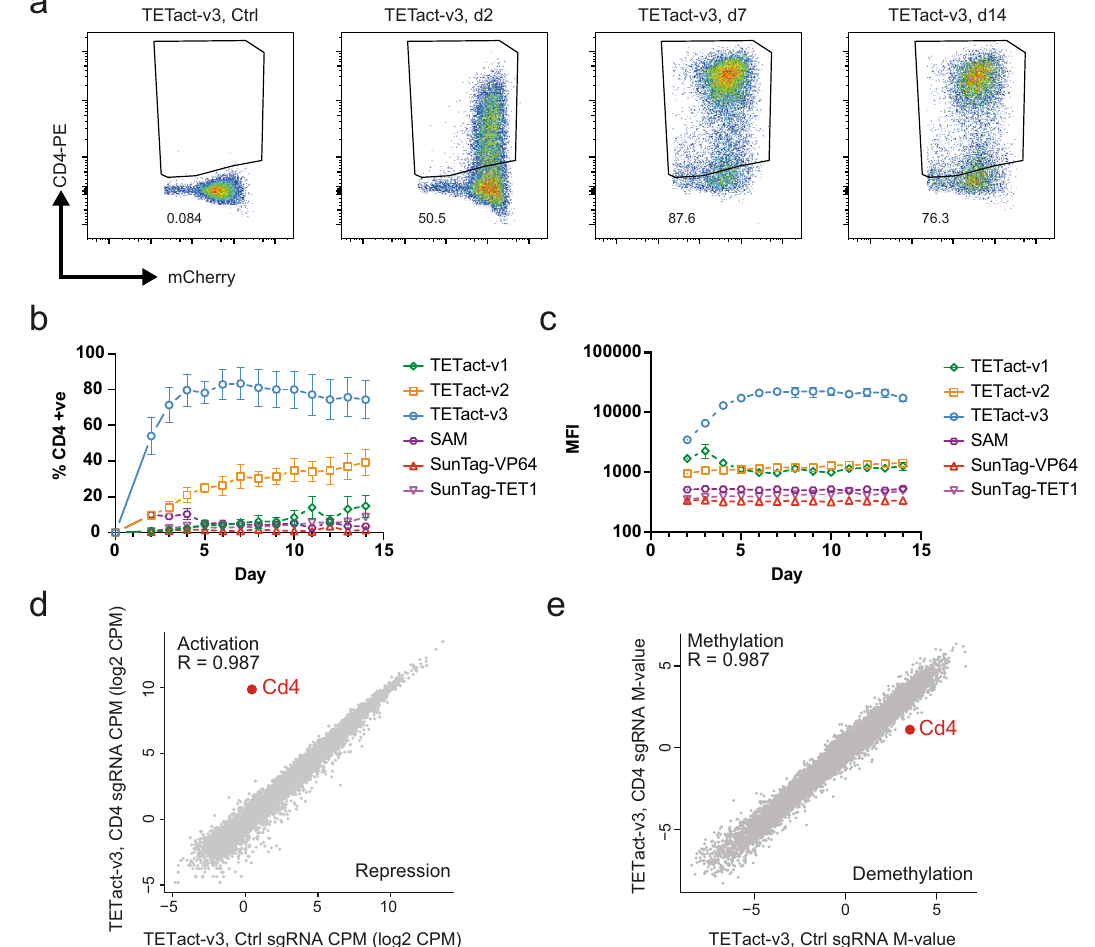
Fig. 2 | TETact is a potent activator of stably silenced genes. a Representative fl ow cytometry plots showing CD4 surface expression in A20-TETact-v3 cells transduced with Cd4 promoter-targeting sgRNA on the indicated day post-sgRNA- transduction. Positive gates for each time point were set against the negative population of cells transduced with control sgRNA on the same day. b Percentage of population with surface CD4 expression over a 14-day time course for A20 cells with various activators as indicated. Data shown are mean±s.e.m. from three independent experiments. c Median fl uorescence intensity (MFI) of CD4-PE of the